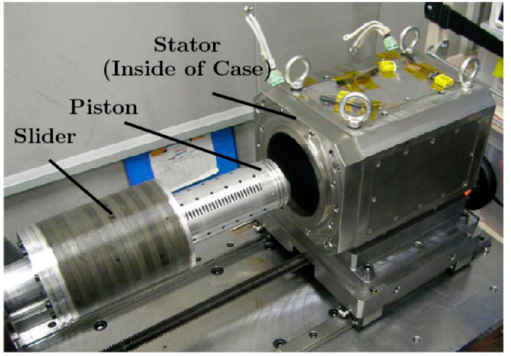
Figure 7. Linear generator structure of the second prototype of Toyota Central R&D [1].